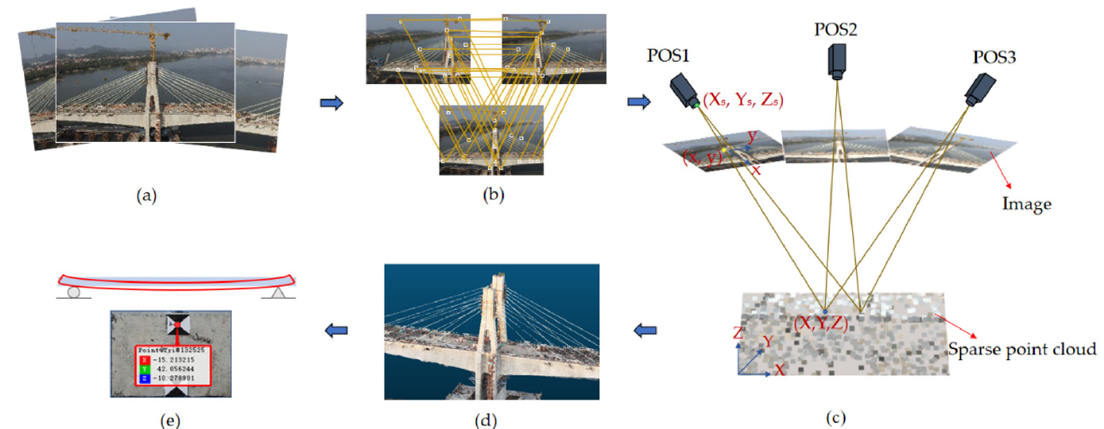
Figure 1. The process of deformation measurement based on oblique photography: ( a ) multi-view image acquisition; ( b ) corresponding points matching; ( c ) aerotriangulation; ( d ) 3D model reconstruction; ( e ) spatial data comparison.